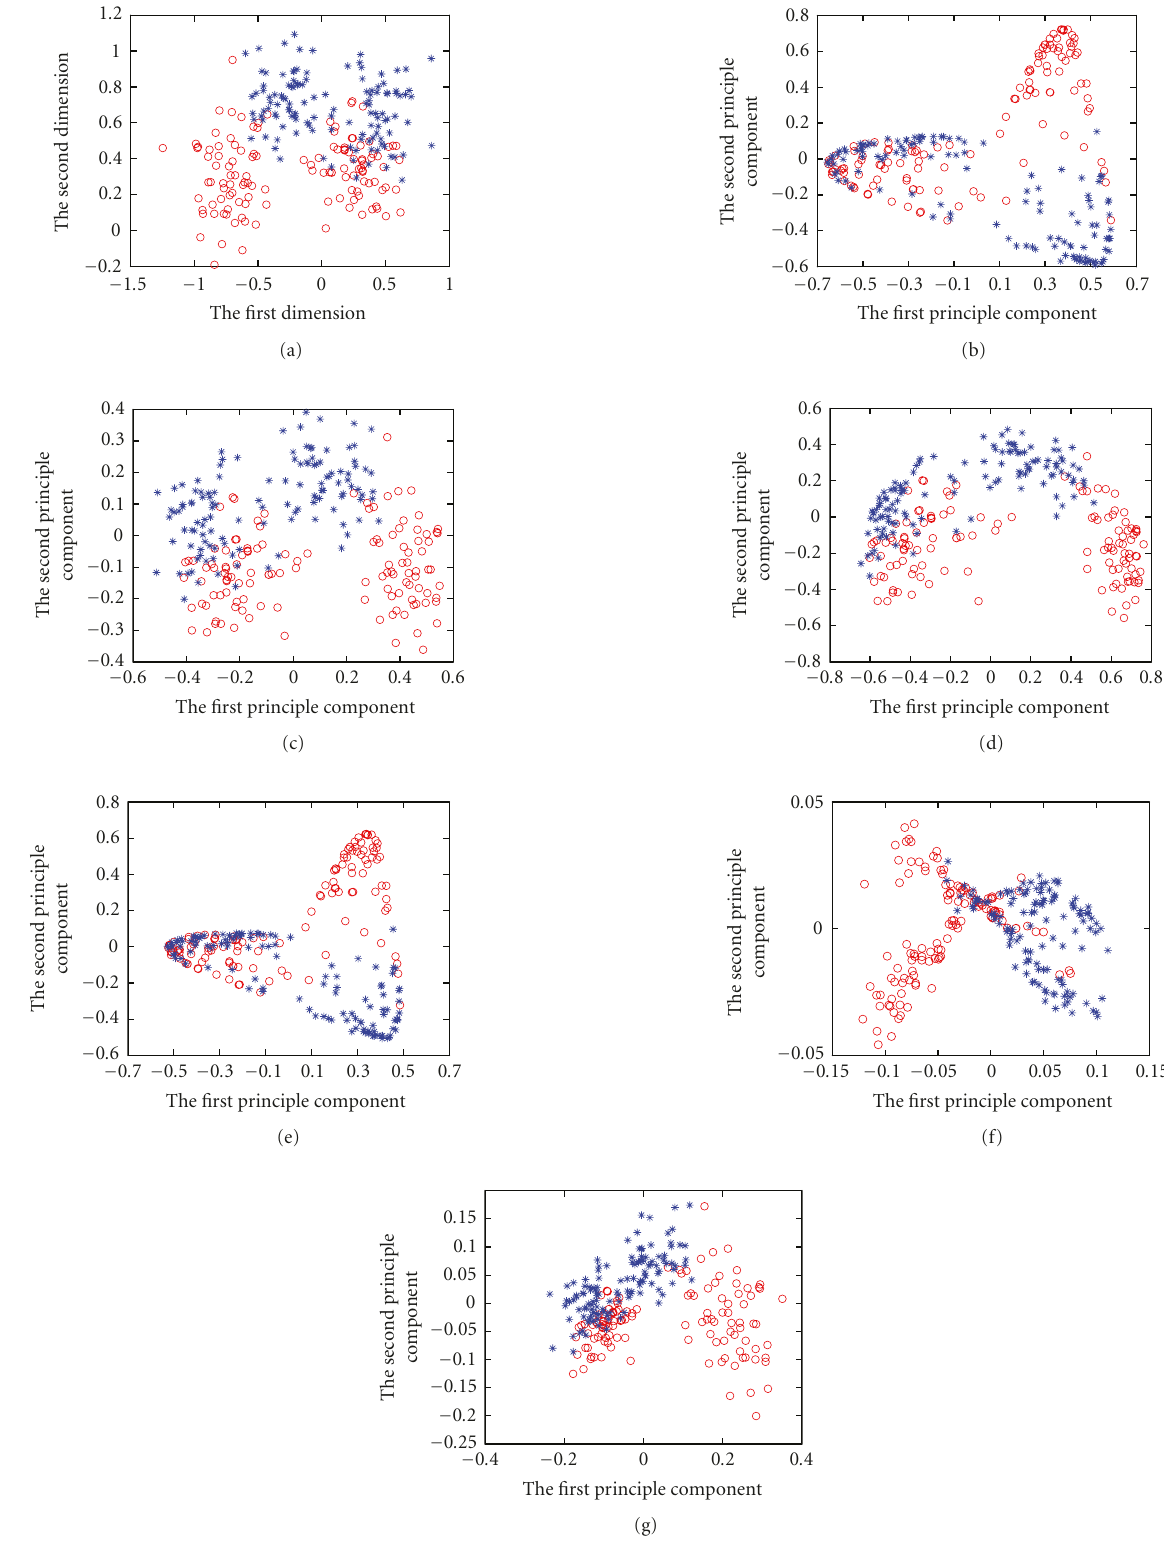
Figure 1: Ripley’s Gaussian mixture data set and its projections in the empirical feature space onto the first two significant dimensions. (a) The original training data set. (b)–(d) two-dimensional projections of the original training data set, respectively, in G10, G0.25, and P2 kernel induced feature space. (e)–(g) two-dimensional projections of the original training data set, respectively, in G10, G0.25, and P2 kernel induced feature space after the single kernel